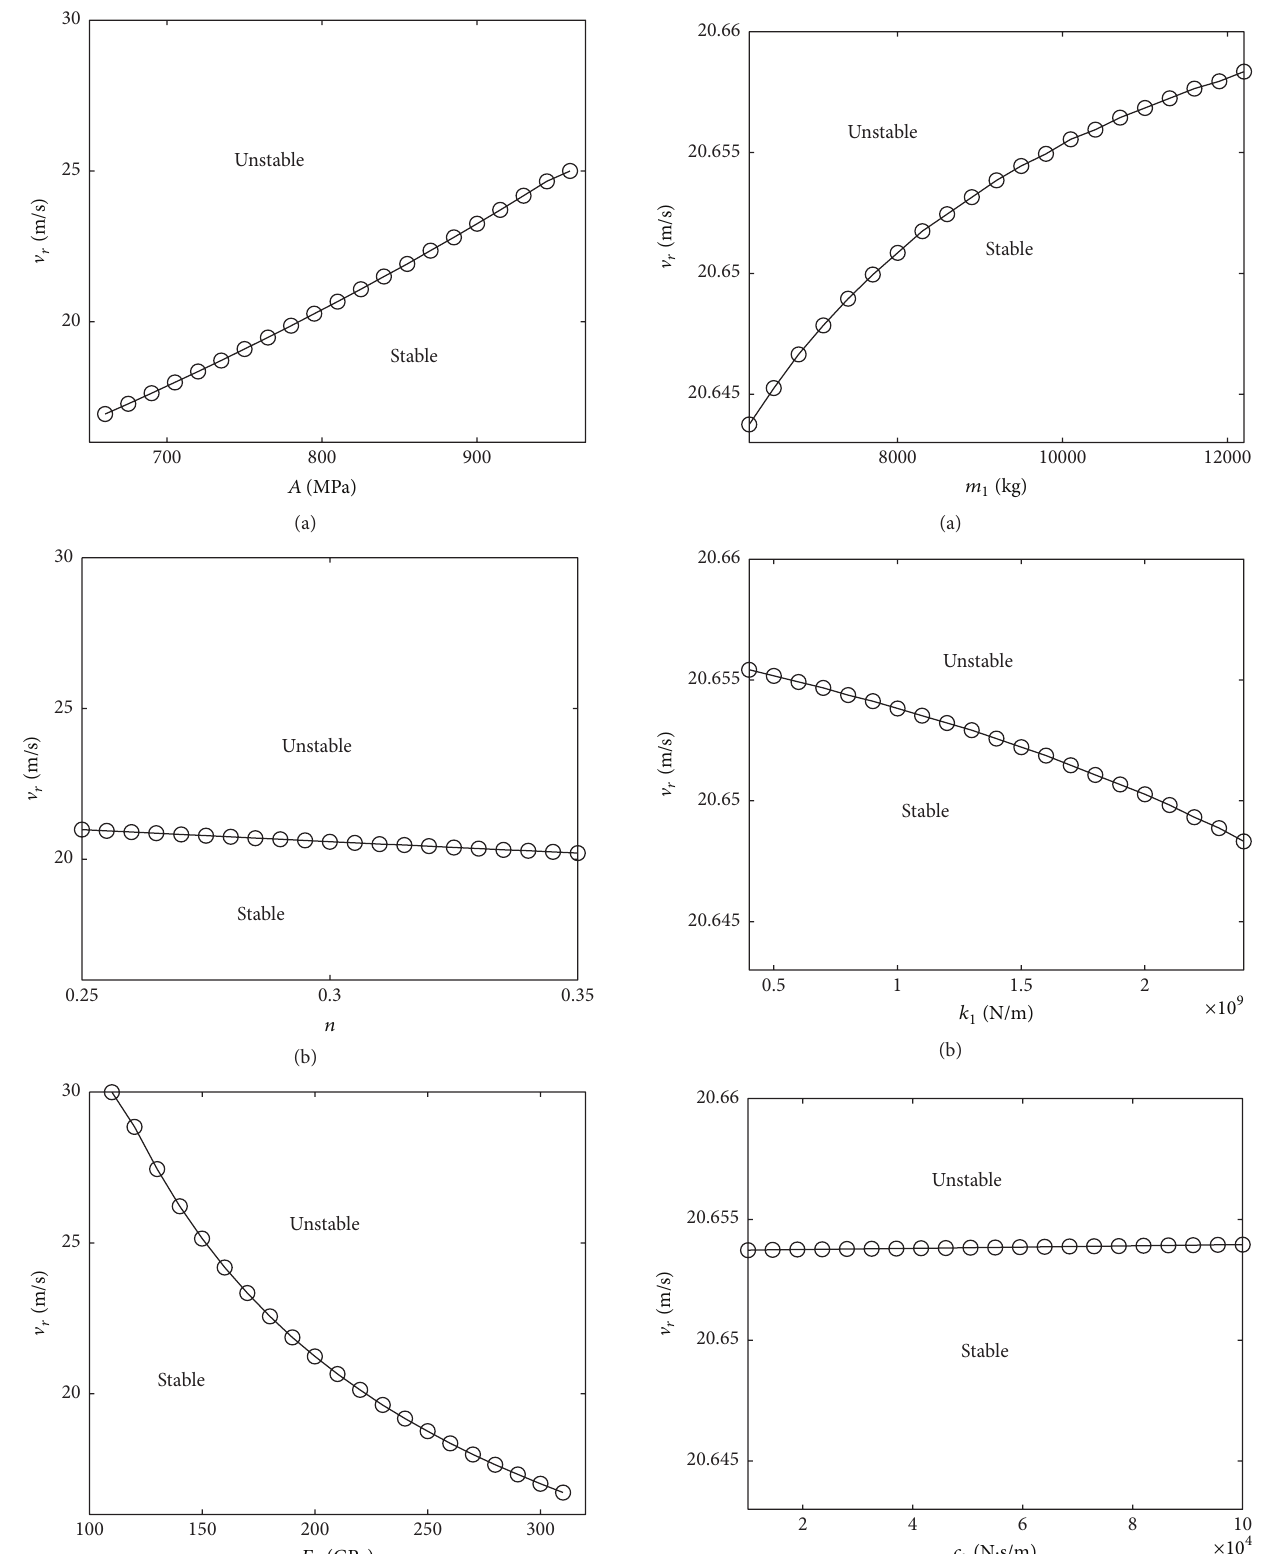
Figure 16: Influences of horizontal structural parameters on system